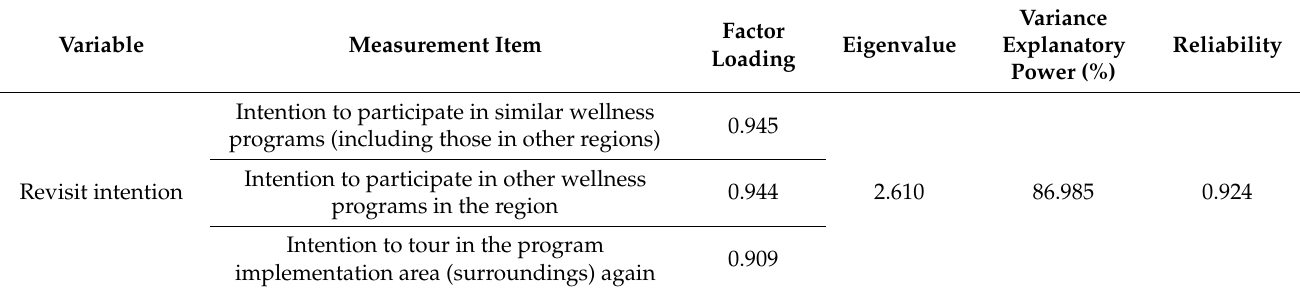
Table 8. Results of factor analysis of measurement items for intentions to revisit wellness tourism